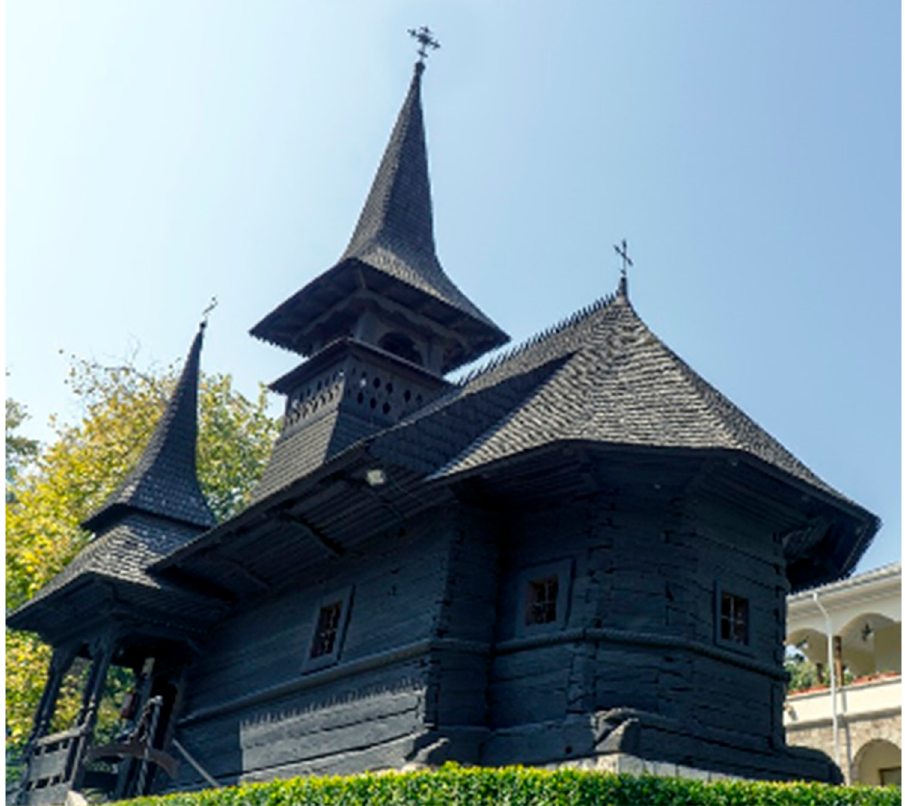
Figure 1. The photo of St. Mary Church, Techirghiol (personal photo) .